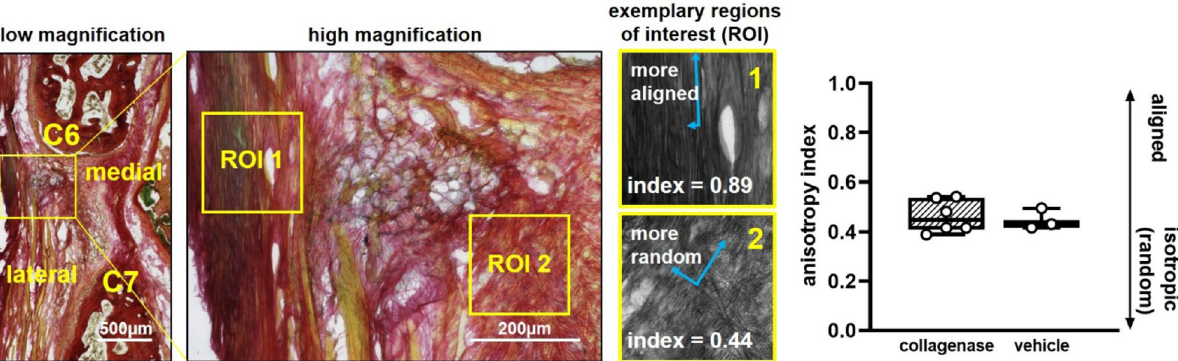
Figure 2. Collagen fiber orientation in the capsular ligament at 21 days after intra-articular injection of collagenase or vehicle. A low magnification image of collagen fibers stained with Picrosirius Red/Alcian Blue depicts the anatomical orientation of a C6/C7 joint. A high magnification image of the capsule in the lateral- to-middle region shows two separate regions of interest (ROIs) from a sample after collagenase injection with principal orientation axes (blue arrows) and their anisotropy indices (white text) overlaid. ROI 1 demonstrates collagen fibers with highly aligned orientation and ROI 2 demonstrates fibers with a less aligned, more isotropic orientation. Intra-articular collagenase (6 joints) does not change the orientation of collagen networks from vehicle (3 joints) (two-tailed t-test; p = 0.731). Box-and-whisker plots show horizontal lines representing the first (lower) quartile, median, and third (upper) quartile of the data; whiskers represent the minimum and maximum of the data set. Data points for individual joints are superimposed on boxplots and are the mean value quantified using 5–6 images/rat and 2–4